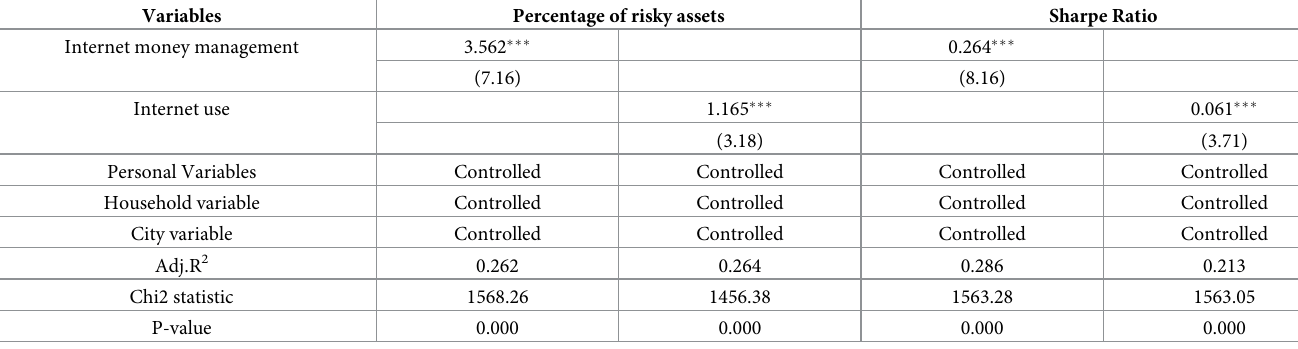
Table 5. Effect of willingness to use Internet finance on the effectiveness of household asset allocation.